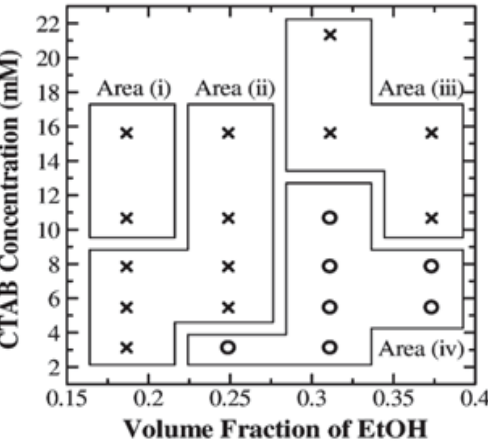
Figure 21. Effect of CTAB concentration on the stability of hollow silica spheres in an aqueous solution. “o” represents uniform monodispersed hollow silica spheres while “ × ” represents failed hollow silica sphere, which includes fused or aggregated hollow silica spheres [84].